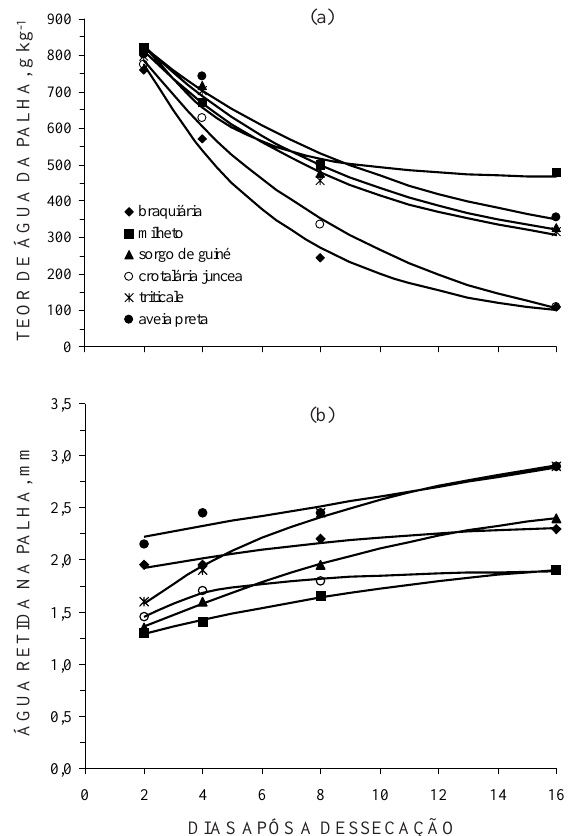
Figura 2. Teor de água das palhas de plantas de cobertura antes de serem submetidas à chuva simulada (a). Retenção de água nas palhas de plantas de cobertura, conforme a simulação de chuva, em diferentes épocas após a dessecação química (b). Valores observados (símbolos) e valores estimados